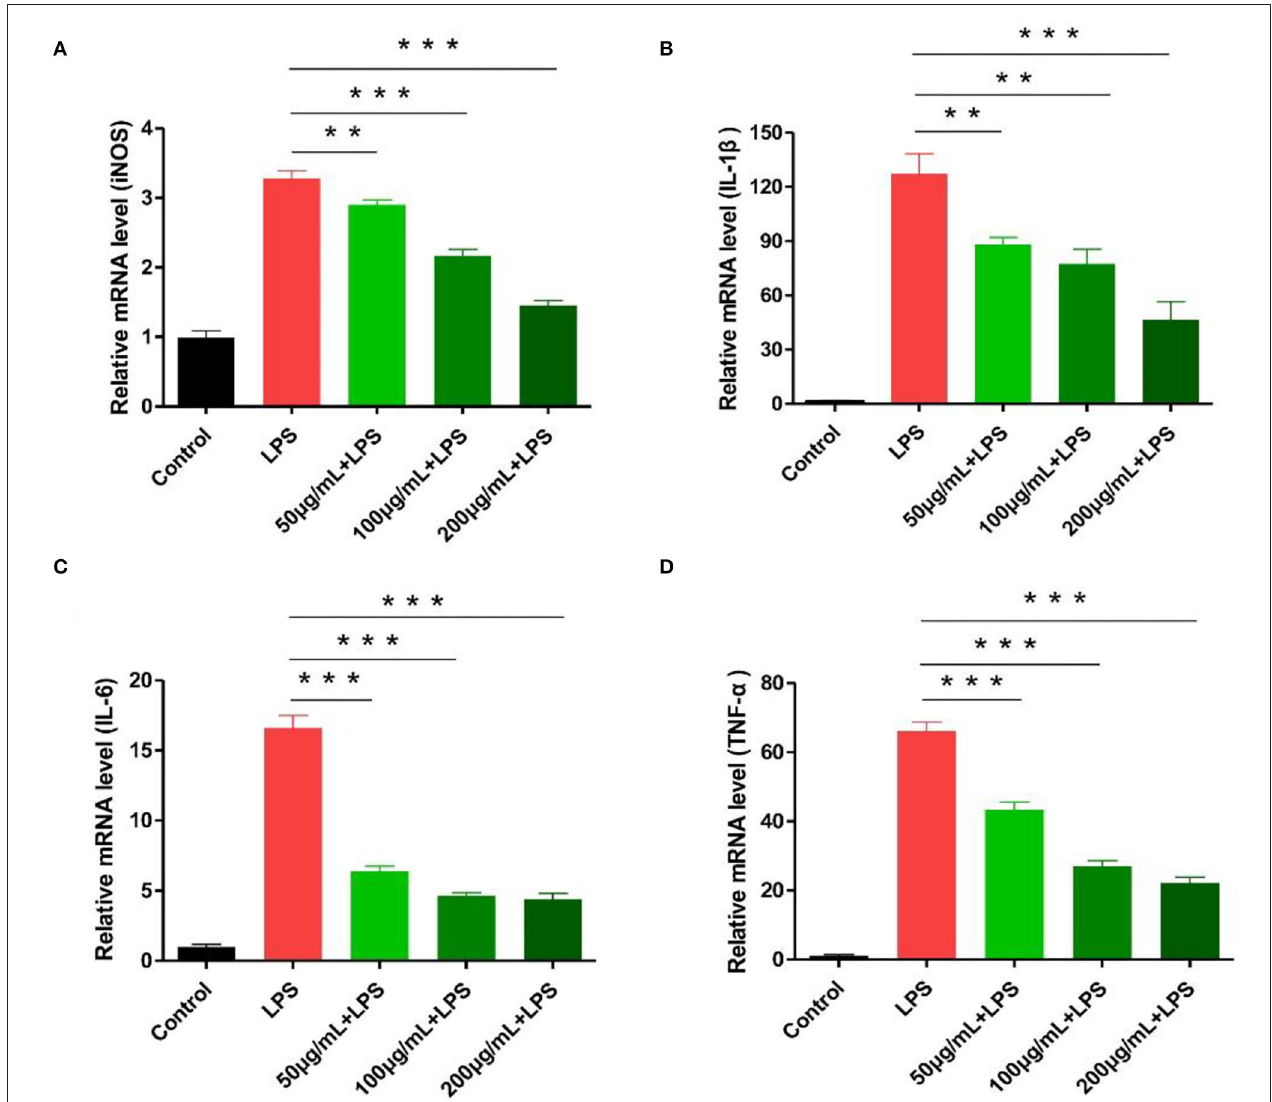
FIGURE 6 | Effect of different RCHP-S concentrations on cytokine secretion [ (A) iNOS, (B) IL-1 β , (C) IL-6, and (D) TNF- α ; ** p < 0.01, and *** p <